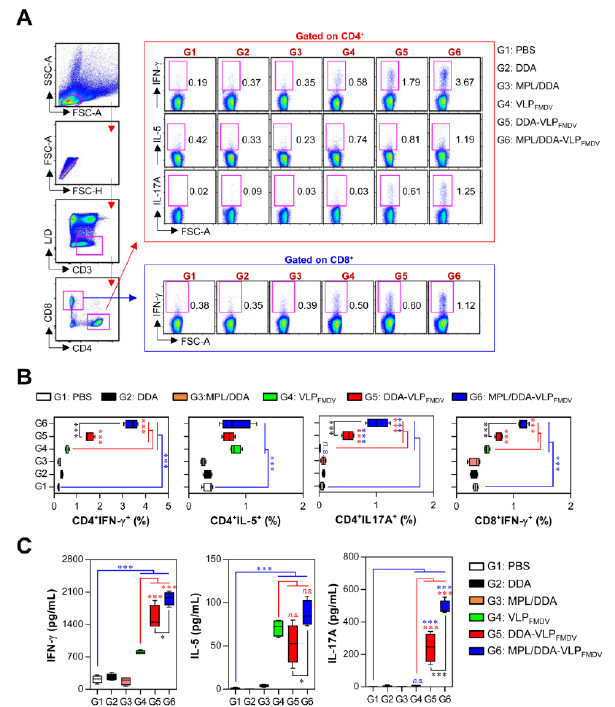
Figure 2. Analysis of VLP-specific CD4 + and CD8 + T cell responses. Mice ( n = 5 animals/group) were